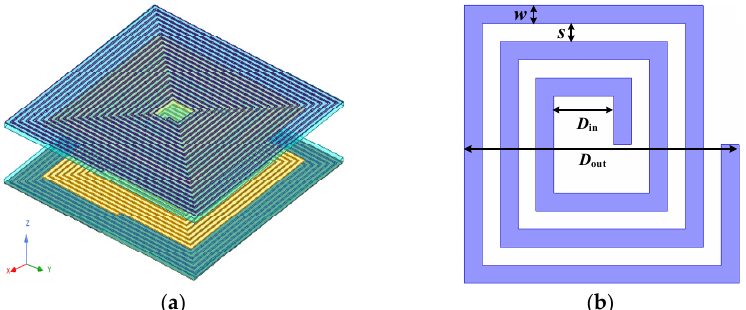
Figure 1. Basic structure of integrated electromagnetic coupler. ( a ) 3D Graph of integrated electro- magnetic coupler. ( b ) Top view of plane rectangular spiral electromagnetic pole.